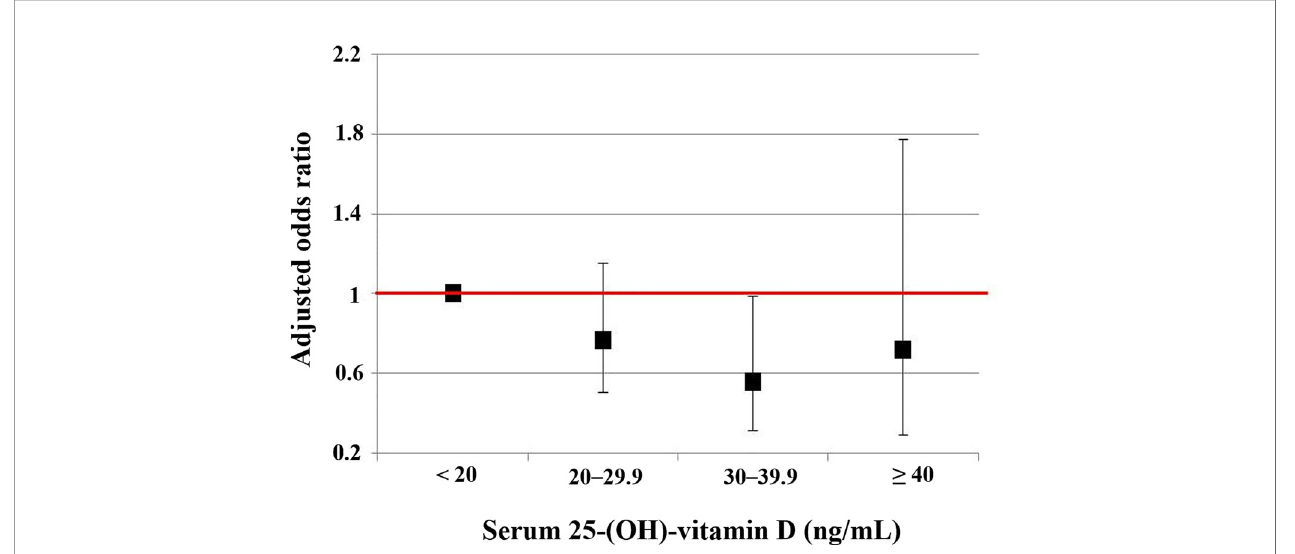
FIGURE 4 | The risks of the very low NKA < 100 pg/mL according to serum level of 25-(OH)-vitamin D compared to normal NKA ≥ 500 pg/mL. This is a result from a multiple regression analysis, and numeric data are shown in the fi rst column of Table 2 . Vertical lines show 95% con fi dence